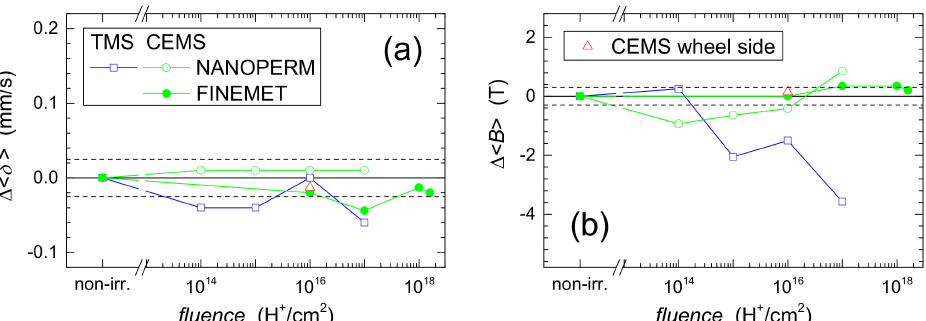
Figure 10. Differences of parameters derived from transmission (TMS, blue) and CEMS (green) Mössbauer spectra of Fe 74 Cu 1 Nb 3 Si 16 B 6 (FINEMET-type, solid symbols) and Fe 76 Mo 8 Cu 1 B 15 (NANOPERM-type, open symbols) metallic alloys irradiated by 37 keV and 80 keV H + ions, respec- tively, plotted against the ion fluence: ( a ) average isomer shift, ∆ (cid:104) δ (cid:105) ; ( b ) average hyperfine magnetic field, ∆ (cid:104) B (cid:105) . Red triangles correspond to CEMS spectra taken from the wheel side of the ribbons. Solid lines are only guides for the eye, dashed lines represent the error margins.